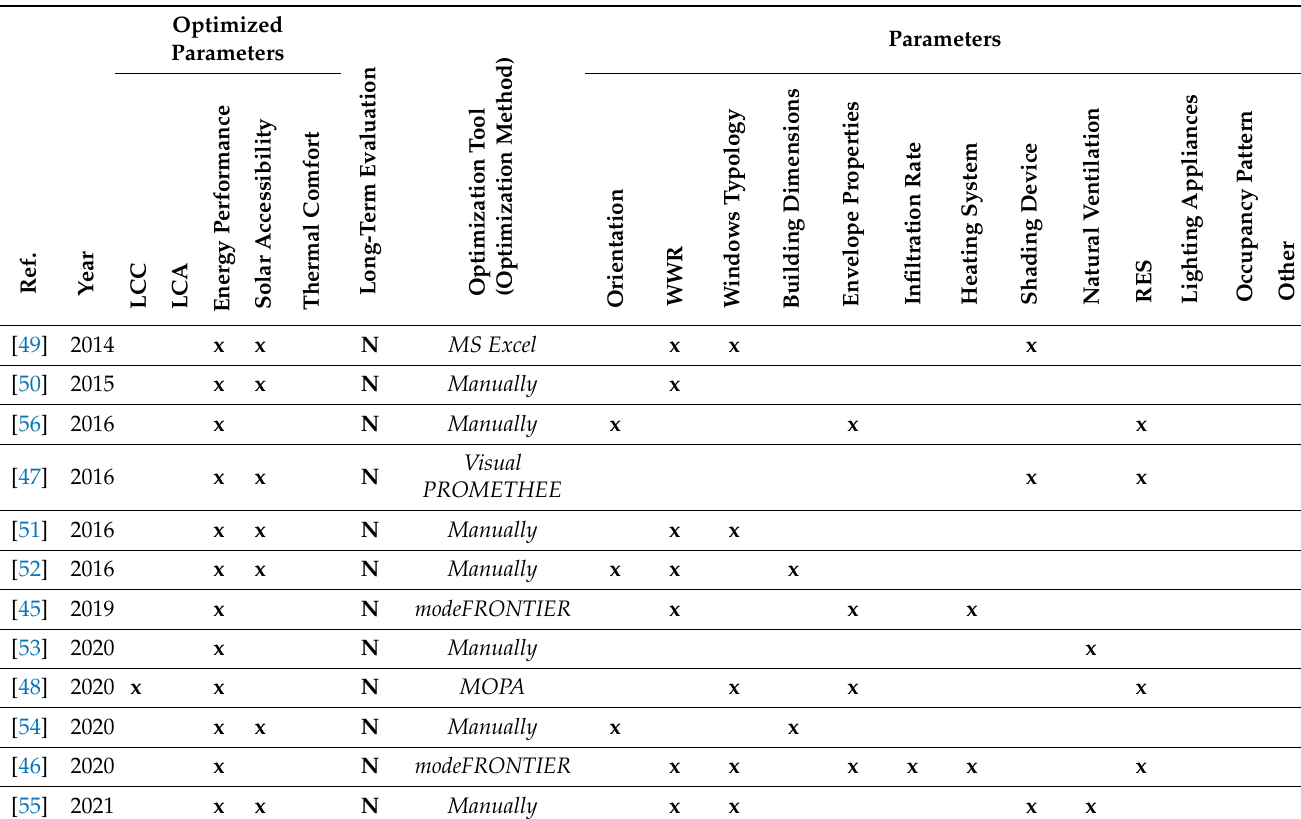
Table 6. Tabular review of journal articles about MOO workflows developed in an unspecified environment or in an environment different from Python, MATLAB, and